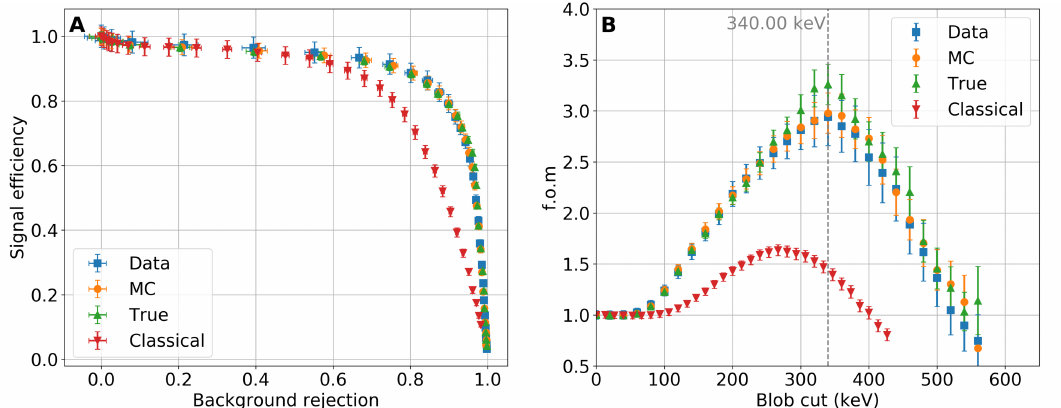
Figure 13 . (A) Signal efficiency vs. background rejection for 1.6 MeV double escape peak events, for detector data, MC (using the fit) and MC (using the true information), for the optimal choice of parameter configuration (marked rectangles in figure 18 in appendix B). The curve resulting from the classical analysis of data (from [35]) is shown for comparison. (B) The figure of merit for the optimal parameter configuration for detector data, MC (fit and true) and classical analysis vs. the threshold on blob2 energy. The maximal (optimal) f.o.m. is for a blob2 energy cut at 340 keV.